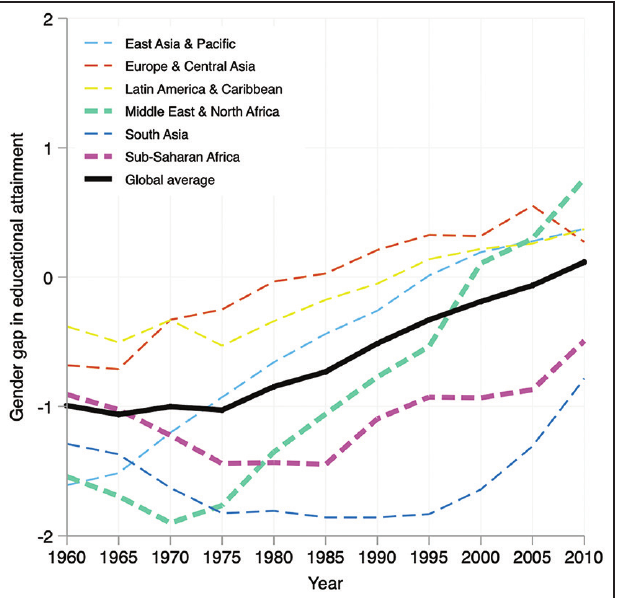
Figure A4 Regional Change in Gender Gaps in Average Schooling Years for Younger Cohort, 1960–2010.